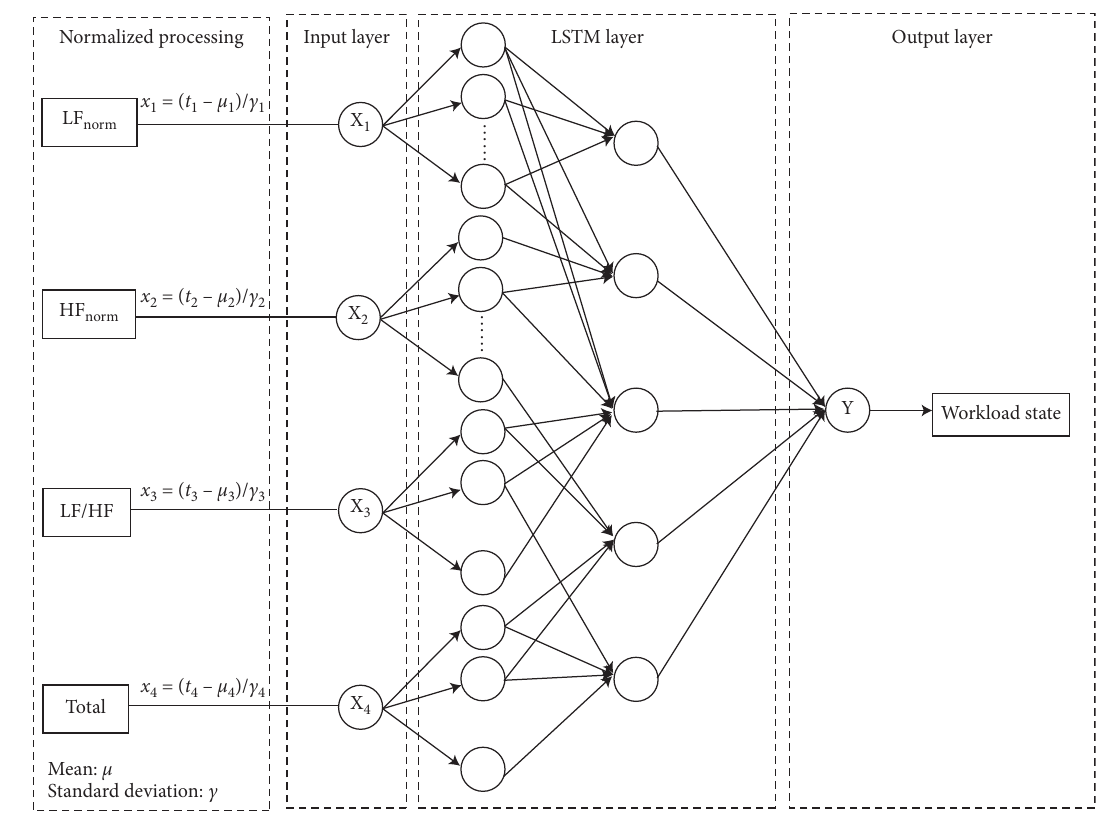
Figure 15: Cognitive load identification model based on LSTM-RNN.